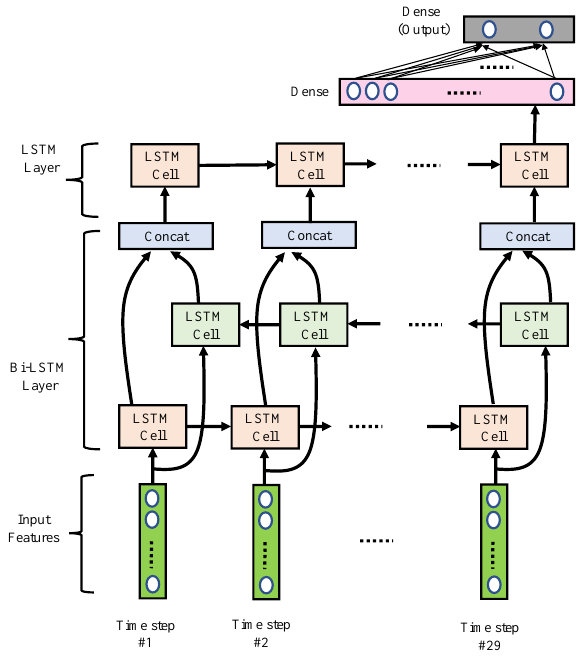
Figure 8. Block diagram of the proposed RNN